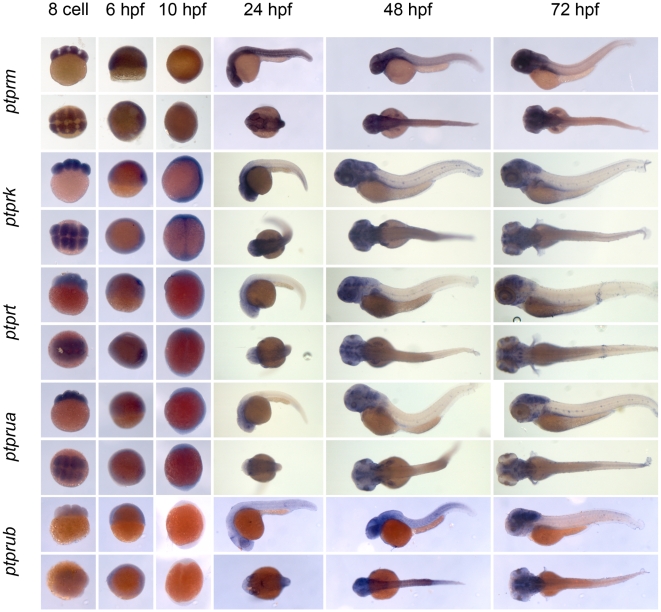
See legend to Fig. 3.